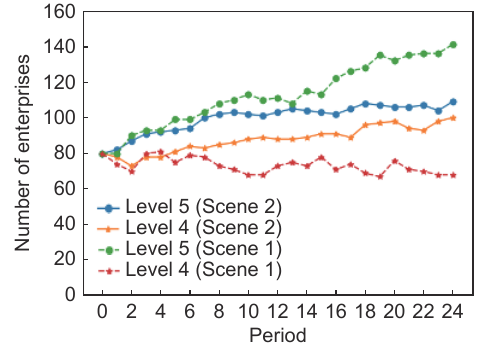
Fig. 2 Scenes 1 and 2: Changes of number of enterprises in Levels 4 and